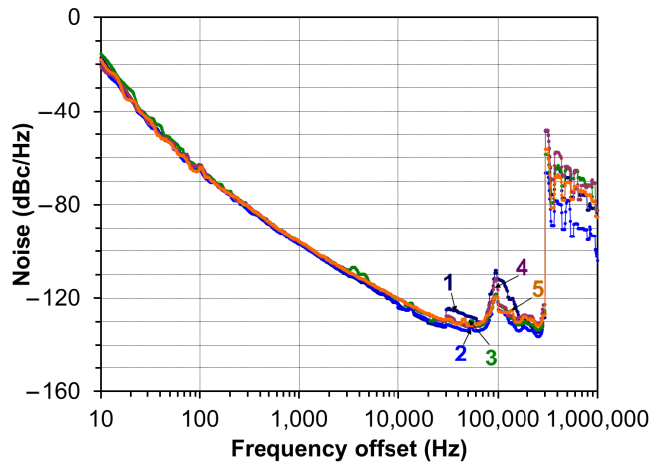
Figure 8. Phase noise in the OEO with the broadband demodulation and tunable YIG filter as a function of the frequency offset at different generation frequencies: curve 1 - 4, 2 - 6, 3 - 8, 4 - 10, and 5 - 12 GHz.